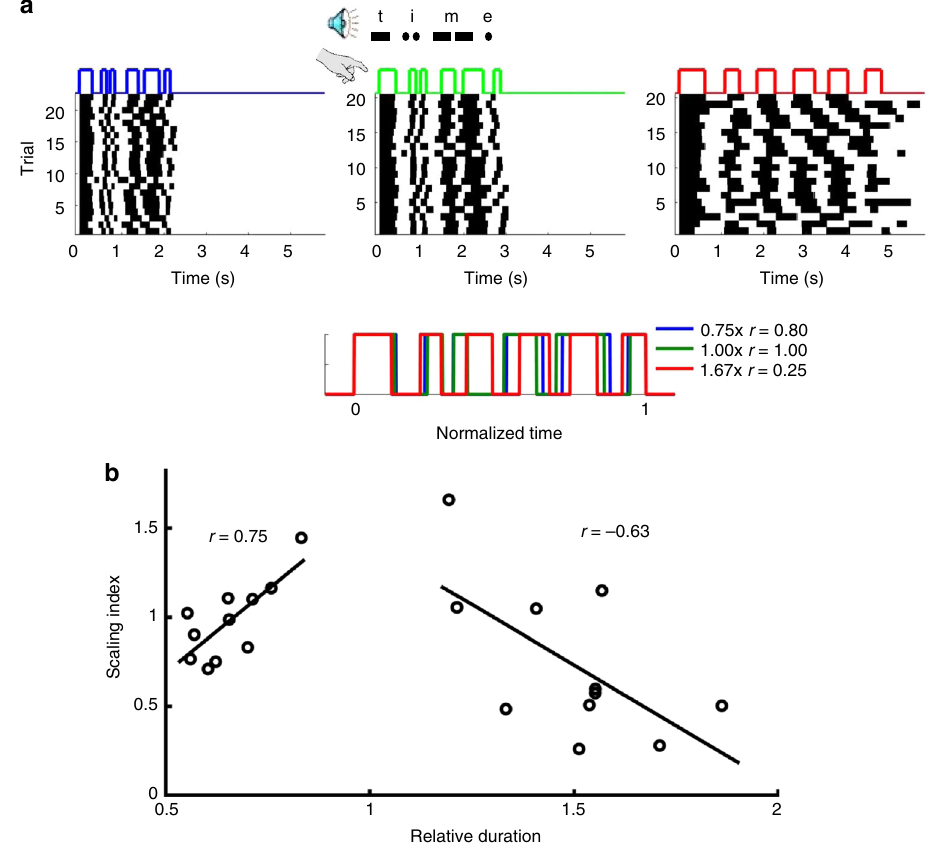
Fig. 1 Limited temporal scaling of a learned Morse code pattern. Subjects were trained to tap the Morse code for “ time ” at a speed of 1× (10 wpm) over four consecutive days (Methods). a On the fi fth day, subjects were asked to produce the pattern at three different speeds: twice as fast (2×), normal speed (1×), and twice as slow (0.5×) (data from a single subject). Bottom: Average of the responses above plotted in normalized time. The legend indicates the produced speed relative to the trained (1×) condition and the correlation of the mean response to the response at trained speed. b The relationship between produced speed and temporal scaling accuracy for all 11 subjects. There was a signi fi cant correlation between speed and accuracy for both the fast ( r = 0.75, p = 0.008, two-tailed t -test) and slow ( r = − 0.63, p = 0.038, two-tailed t -test)